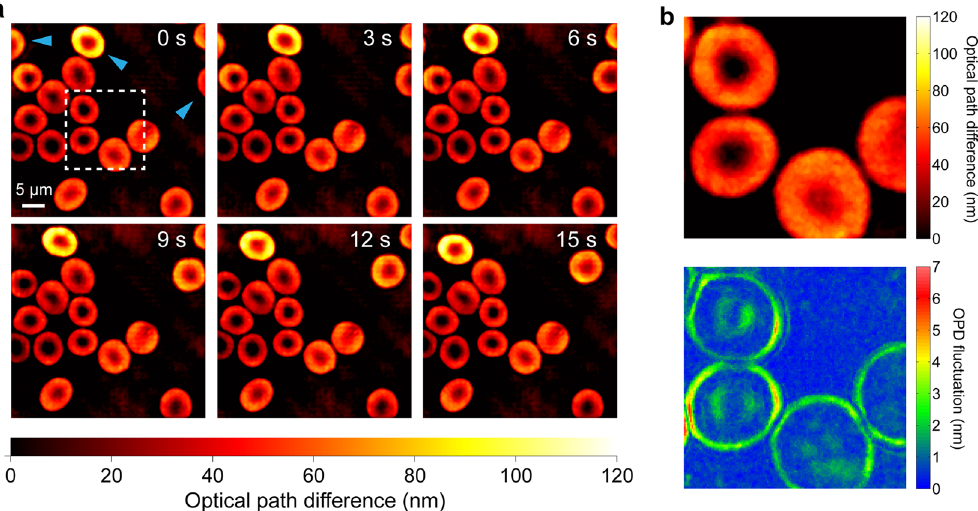
Figure 8. RBC dynamics extracted in real time using WSEIM. ( a ) Time-elapsed phase imaging results of the RBCs flowing in blood plasma in 15 seconds (full time sequence available as Supplementary video S2). Most of the RBCs in the field of view remained in the same position while only those pointed with blue arrowheads were moving. The central region inside the dashed box is zoomed in ( b ), and its OPD standard deviation resulting from the membrane fluctuation of RBCs is also presented